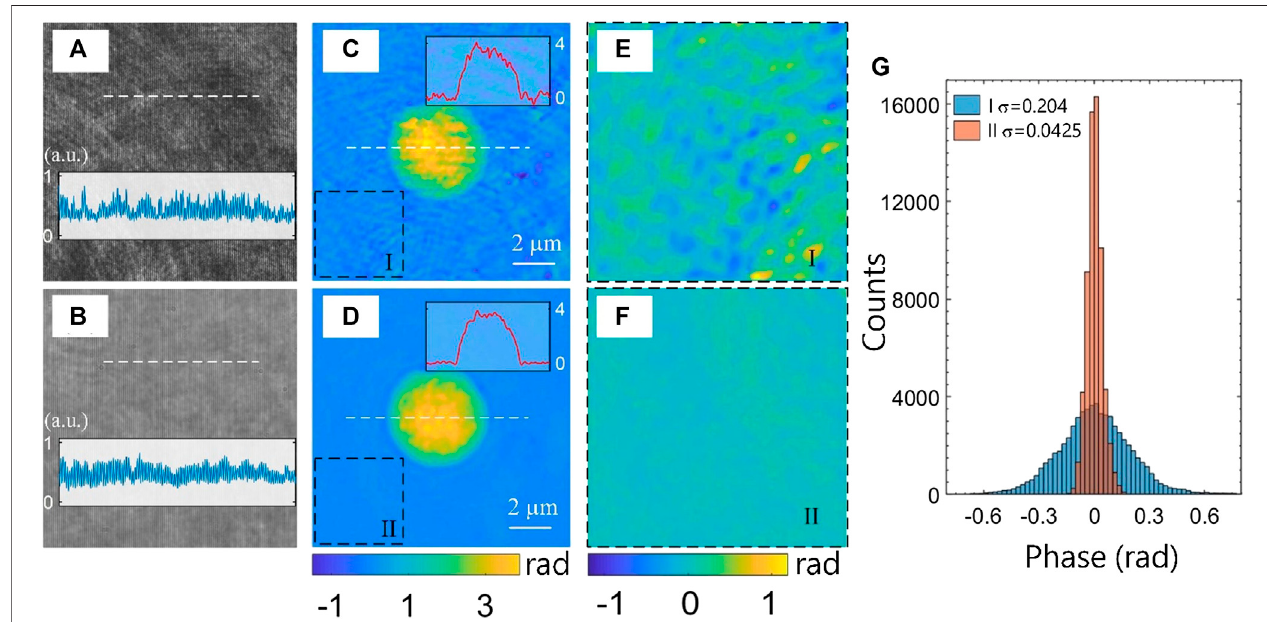
FIGURE 2 | Comparing the SICA and LC-SICA modules by quantitative phase imaging of a polymer bead. (A, C) Hologram and quantitative phase map from the SICA module, with highly coherent illumination (He – Ne, 633 nm). (B, D) Hologram and quantitative phase map from the LC-SICA module, with low-coherence illumination(638 ± 22 nm).Thesame5- μ mpolystyrenebeadimmersedinindex-matchingoilwasimagedinbothcases.Thetwobackgroundregions,markedasIandII in (C) and (D) at the same location, are magni fi ed in (E) and (F) , respectively. (G) Histogram of the phase values of the two background regions I and II, demonstrating a signi fi cantly lower spatial noise in the LC-SICA module in comparison to the regular SICA module. σ denotes spatial standard deviation of the quantitative phase values.